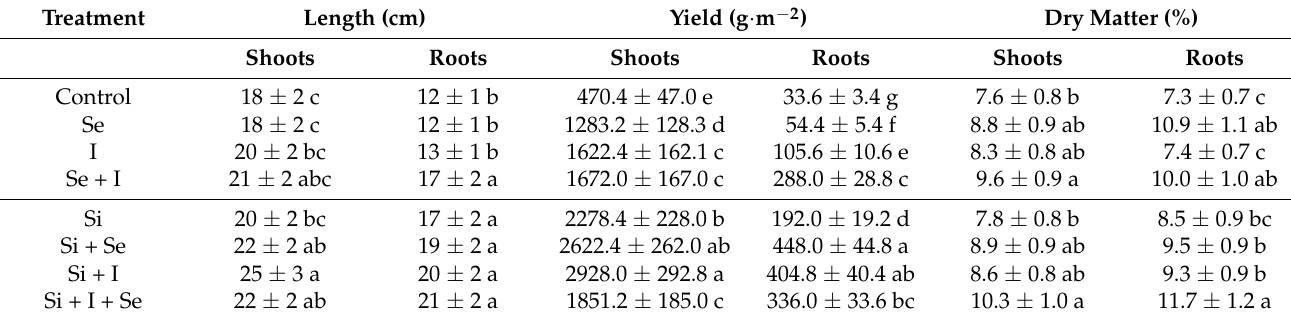
Table 1. Yield, dry matter, and biometrical parameters of chervil under Se, I and Si supplementation. Treatment